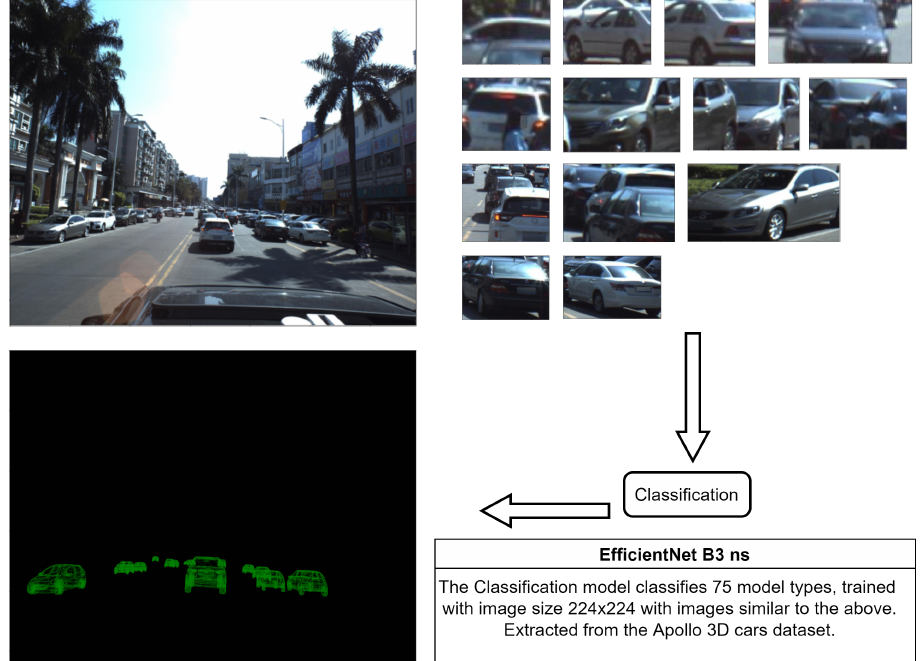
Figure 7. Visualization example for the classification process and data